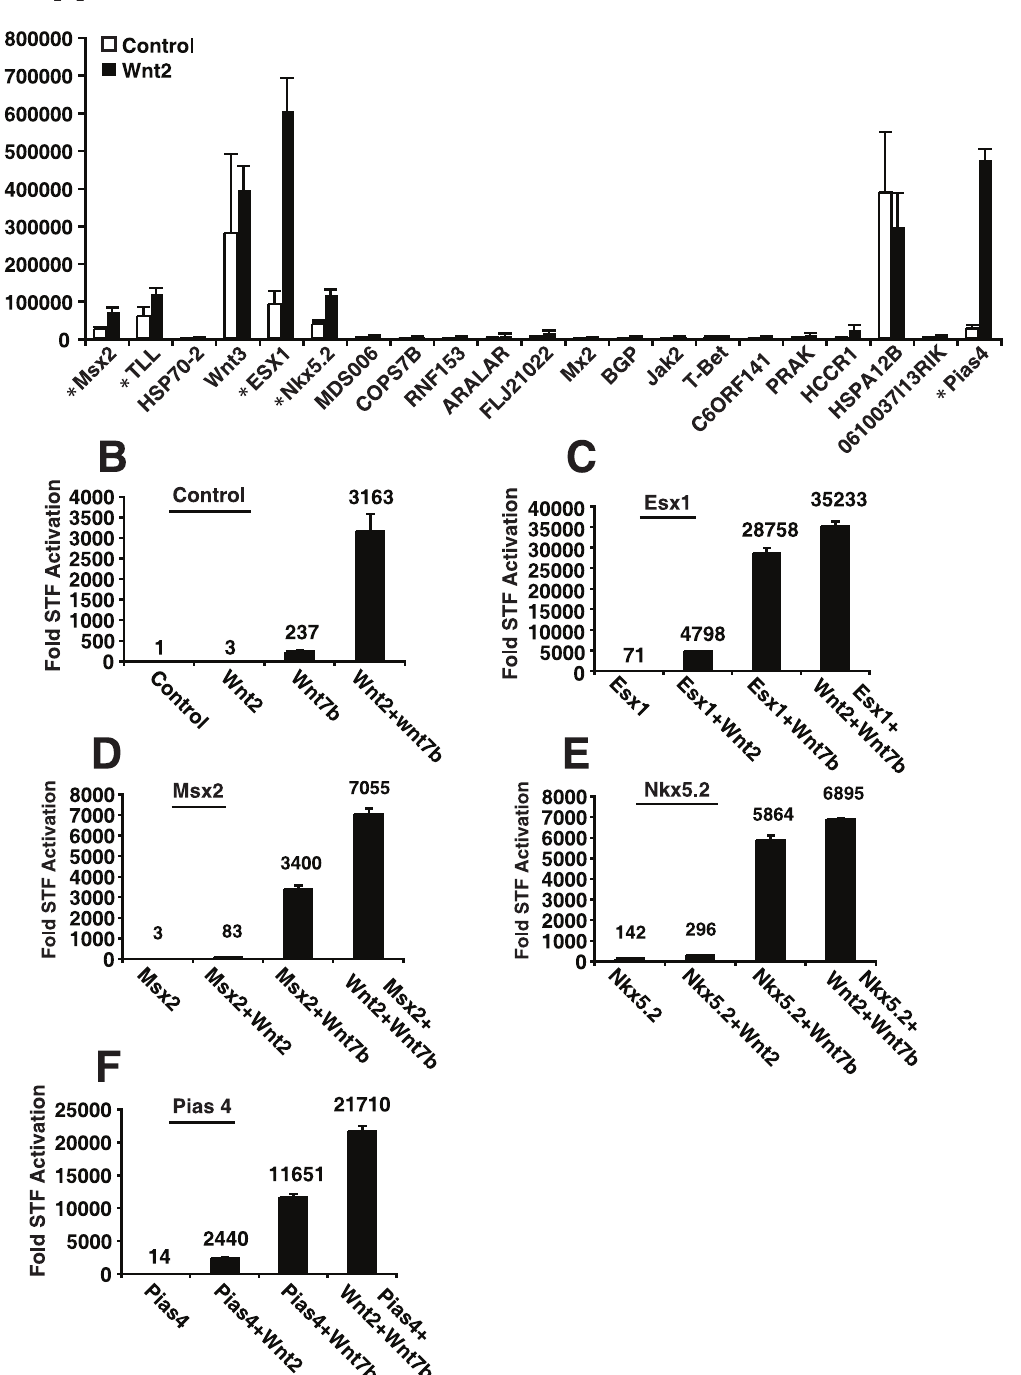
Figure 2. Homeobox factors Msx2, Esx1, Nkx5.2 as well as Pias4 were identified in a HTS screen for factors that cooperate with Wnt2. (A) The 23 hits that were obtained in the HTS screen were repeated in a 96-well format. Two of the hits, Wnt3 and HSPA12B, activated the STF reporter in the absence of Wnt2 and did not cooperatively promote signaling in the presence of Wnt2. The five genes specifically acting with Wnt2 are denoted by (*). Wnt2 plus Wnt7b cooperatively activates STF (B). Expression of Esx1 (C), Msx2 (D), Nkx5.2 (E), and Pias4 (F) further promotes this cooperative signaling in the presence of Wnt2 or Wnt7b. Data represent average of three assays performed in triplicate + S.E.M.